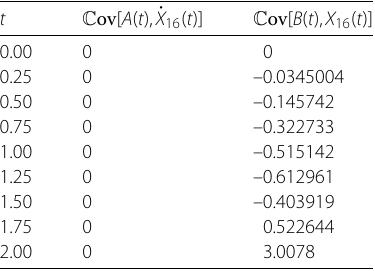
Table 9 Approximation of C ov [ A ( t ), ˙ X ( t )] and C ov [ B ( t ), X ( t )] via accurate truncations ˙ X 16 ( t ) and X 16 ( t ), respectively. Example